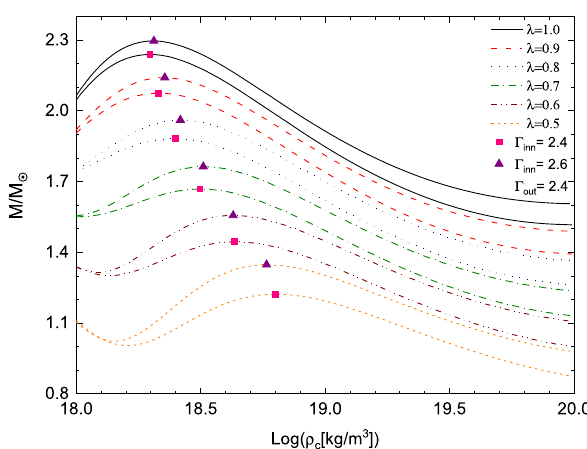
Fig. 2 Mass against the central energy density for different values of λ , ρ dis = 8 × 10 17 [ kg / m 3 ] , Γ inn Γ